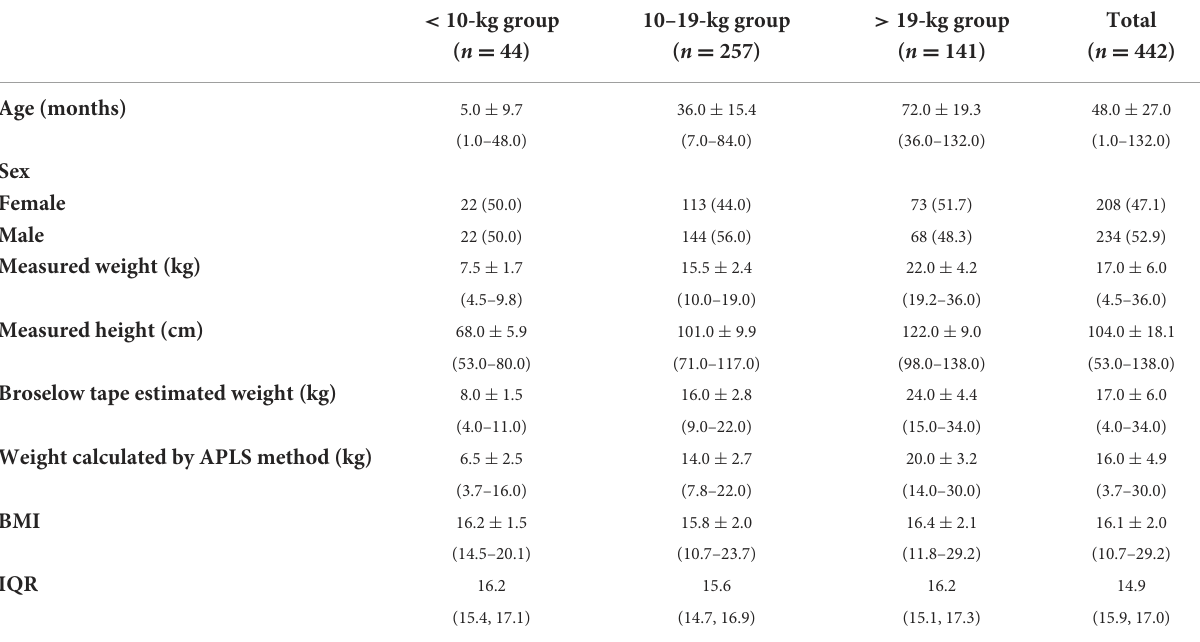
TABLE 1 Characteristics of the children ( n = 442).